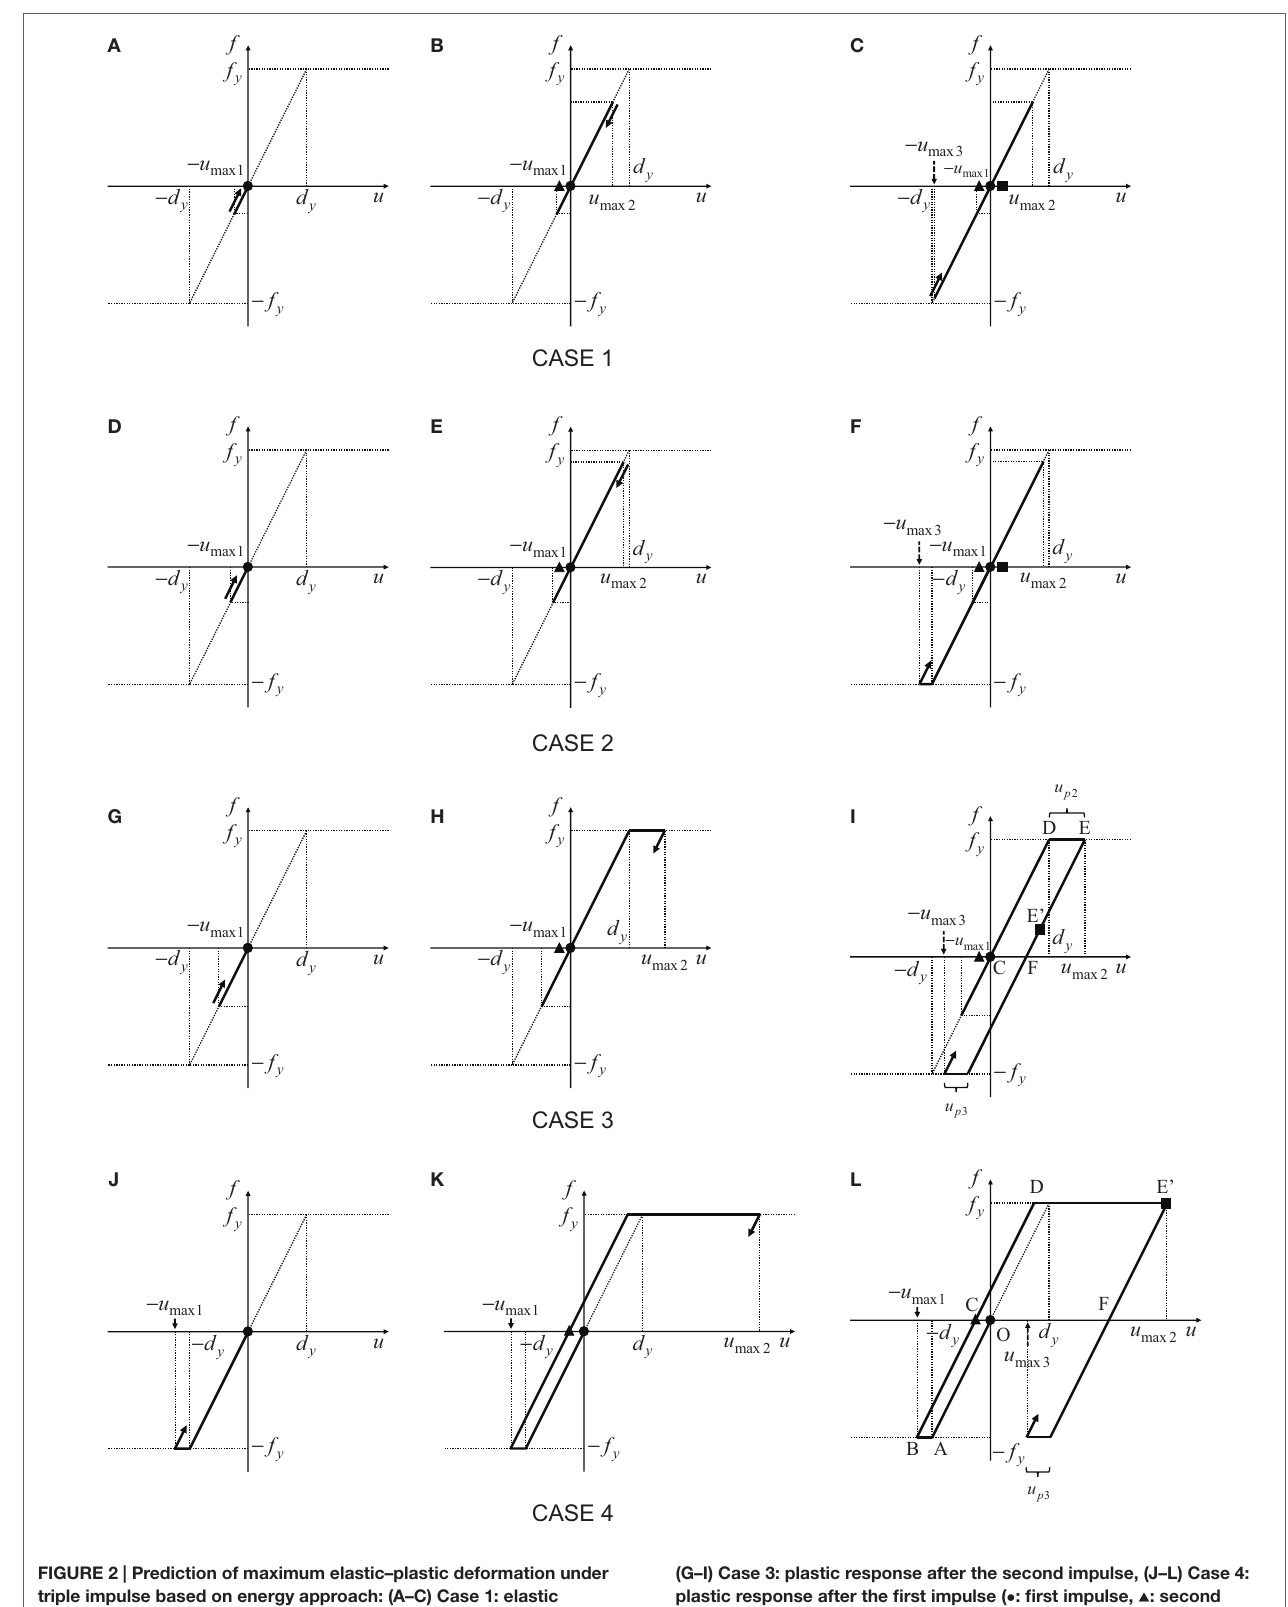
FigUre 2 | Prediction of maximum elastic–plastic deformation under triple impulse based on energy approach: (a–c) case 1: elastic response, (D–F) case 2: plastic response after the third impulse,